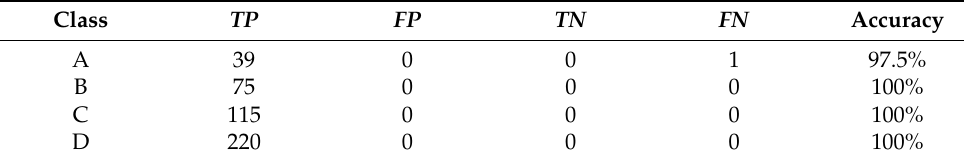
Table 7. Re-classified results for TP , FP , TN , and FN .